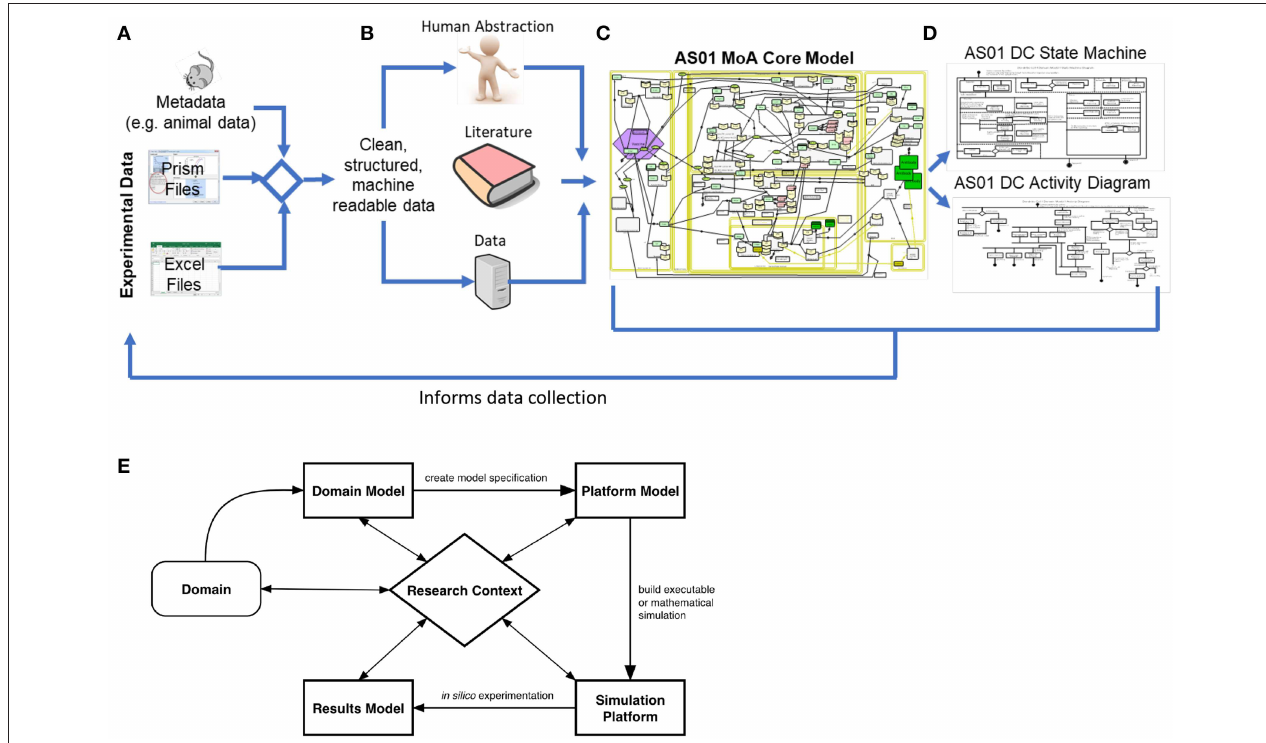
FIGURE 1 | Development of the Domain Model: in this context, development of the domain model began with (A) the collection of experimental data from Graphpad Prism and Excel files, and the corresponding experiment metadata. Following this, an automated pipeline was developed to clean, structure, and integrate the experimental results and the corresponding metadata, resulting in machine-readable data. Next, human abstraction, the AS01 data and immunological literature were appropriately integrated (B) . The AS01 data informed the development of the model 2-fold, firstly by constituting the available evidence behind the captured processes, but also by informing the rationale underpinning any human abstraction required to inform gaps in understanding. The core MoA model (C) was utilized to scope the requirements of the lower-level models describing component function, and so from the core MoA model, state-machine and activity diagrams were developed (D) . Furthermore, Domain Model development can inform data collection by permitting the understanding of what data is required to ask the scientific question. (E) An overview of the CoSMoS process. The system of interest, in this context a biological system, is known as the domain. From this, the current scientific understanding of the system is modeled with respect to the research context, and encapsulated in the “Domain Model”. From this, and often after a process of refinement driven by the scientific question, a software blueprint called a Platform Model is developed. At this stage, further abstractions may be necessitated, based on available computational resources or model simplifications, which are decisions that should be documented as part of the Platform Model. Following this rigorous process builds confidence in the model and simulation, improving the likelihood that the simulation is a “fit for purpose” representation of the biological system (43–45). The simulation platform is an executable piece of software written in computer code, that implements the Platform Model, while the results model encapsulates the understanding that is generated from the